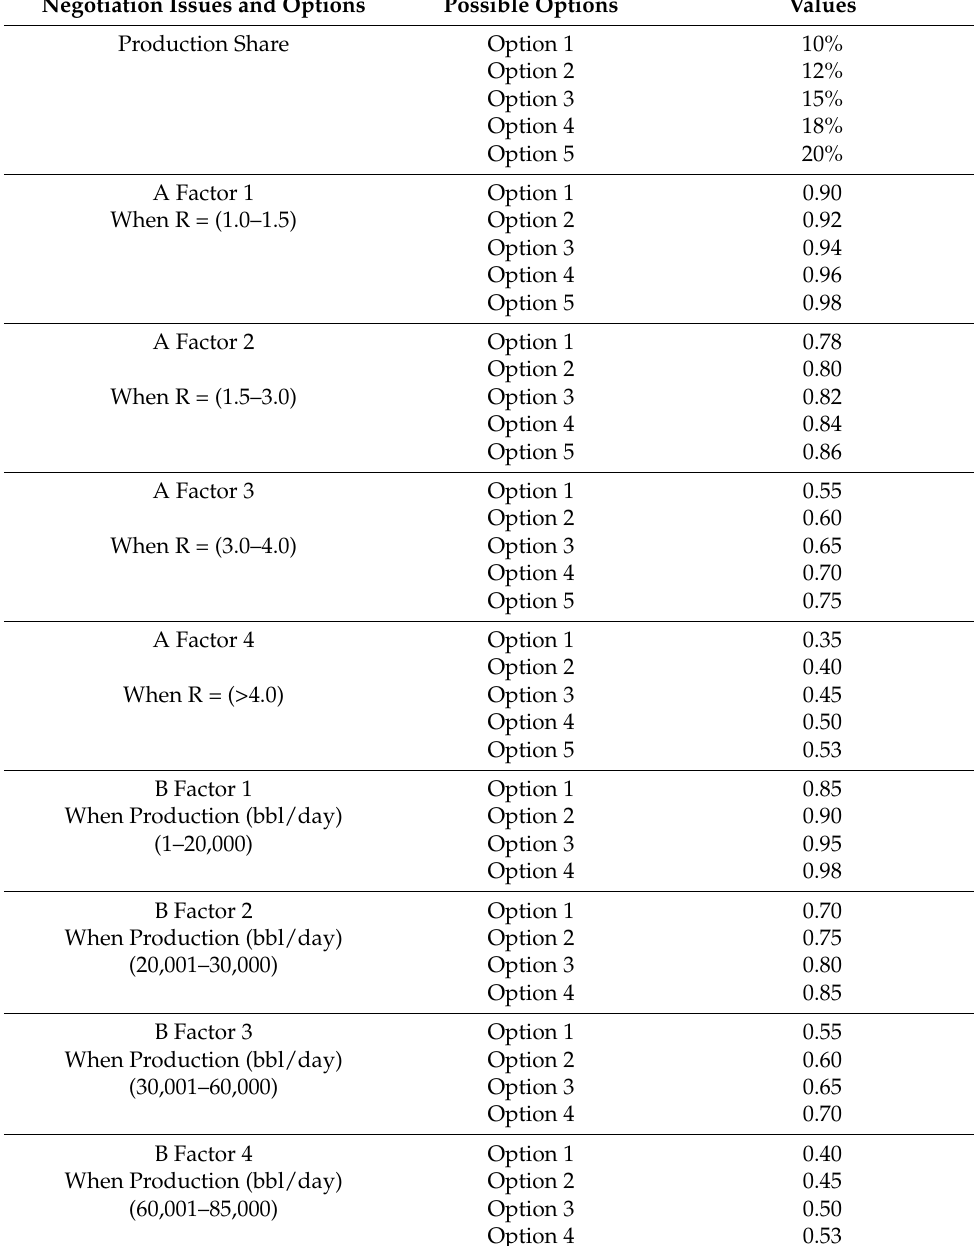
Table 5. The nine issues and options for the NOC and